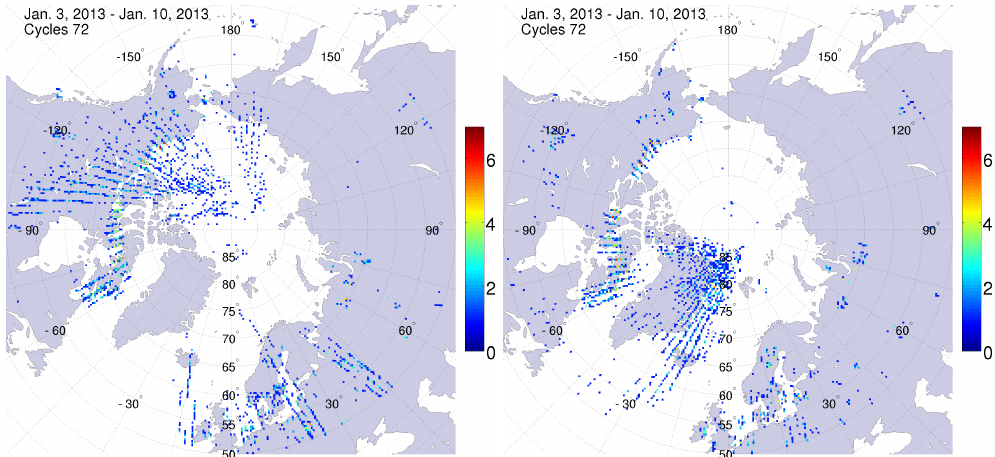
Fig. 1. Map of radio frequency interference (RFI) occurrences (the number of footprint with either a moderate or severe RFI contamination) during cycle 72 (3–10 January 2013) in the Northern Hemisphere for ascending (left) and descending (right) orbits.